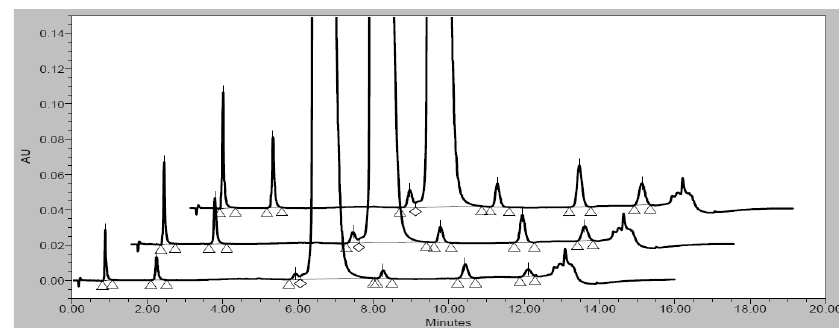
Figure 8. Overlay chromatograms of accuracy (at 50%, 100% and 150%) LOD and LOQ